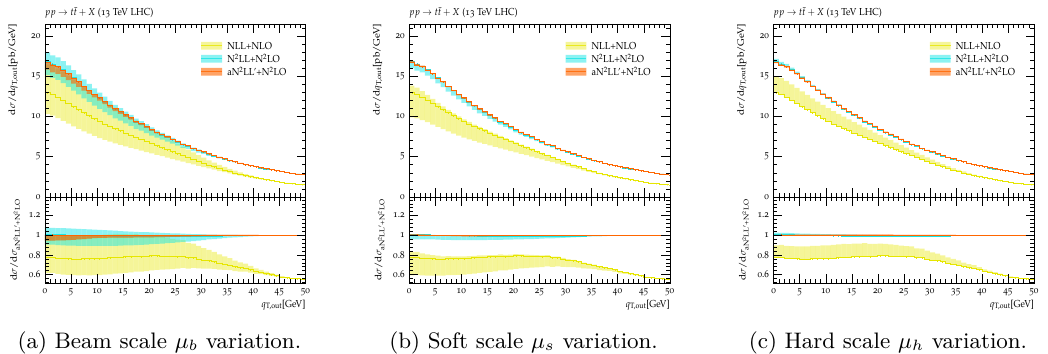
Figure 13 . Dependence on the virtuality scales associated with the beam-collinear, soft, and hard sectors of the differential cross section d σ